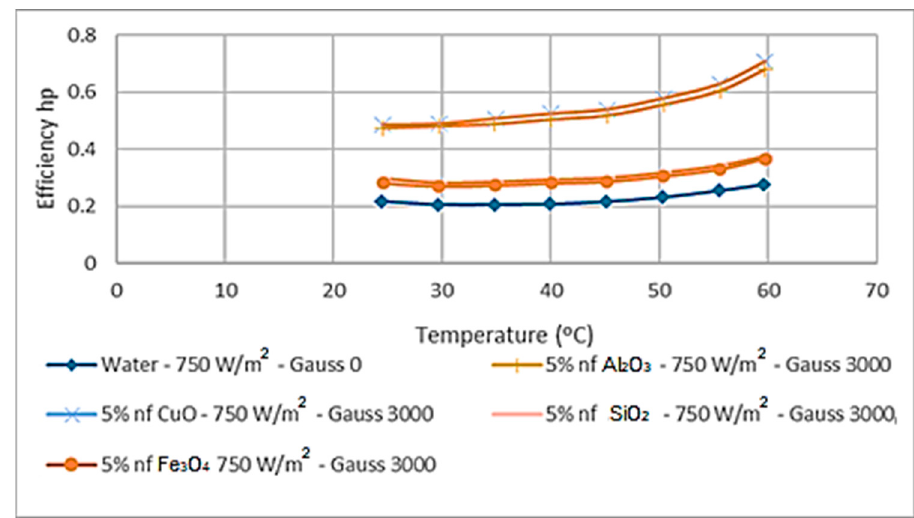
Figure 23. Thermal energy released in heat pipe condenser section.